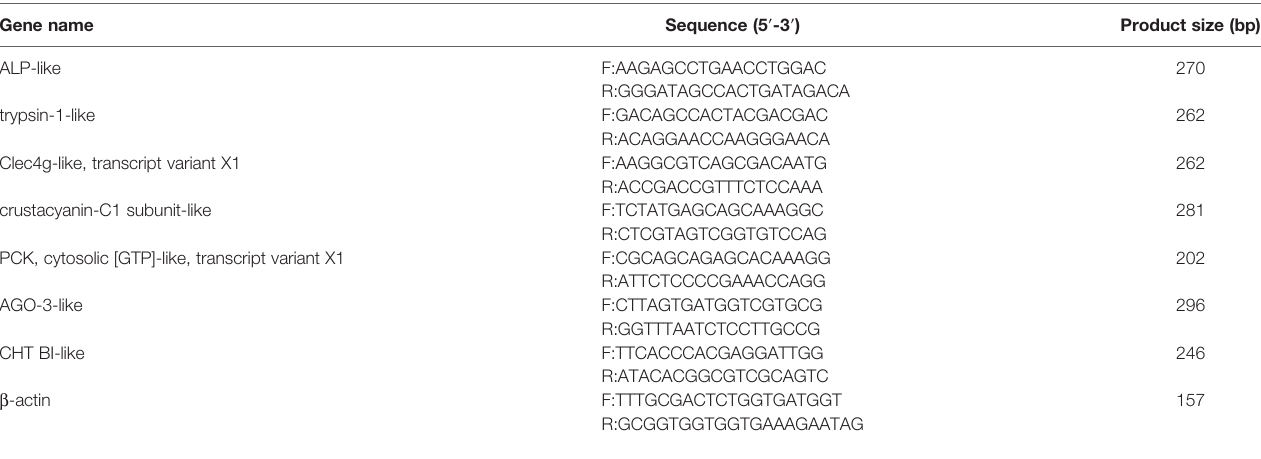
TABLE 1 | The primer sequences used for